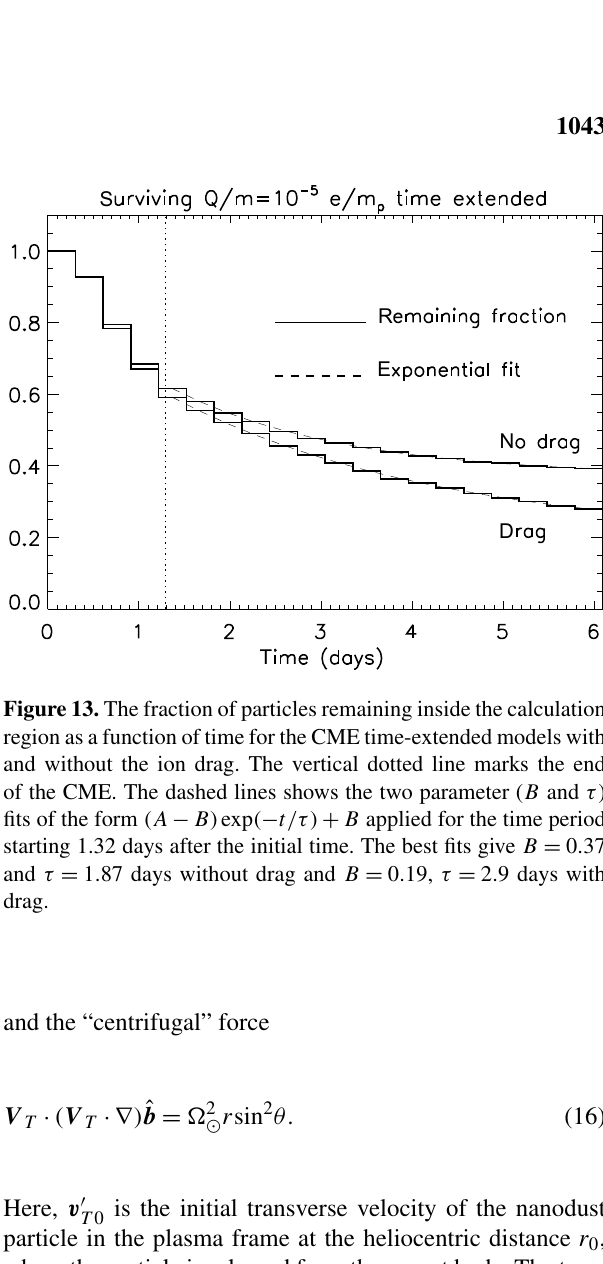
Figure 12. Cumulative fraction of particles escaping from the com- putational domain as a function of time for a time-extended (33 days long) simulation including the ion drag. Rapidly escaping particles (39%) are not included in the figure. The result implies that only ∼ 6% of all particles remain inside at the end of the calculation: 100–39% (rapidly escaping), − 55% (present figure). A rough esti- mation of the characteristic escape time gives ∼ 10 days.